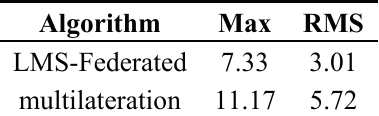
Table 2. Statistics of Euclidean distance errors (unit: